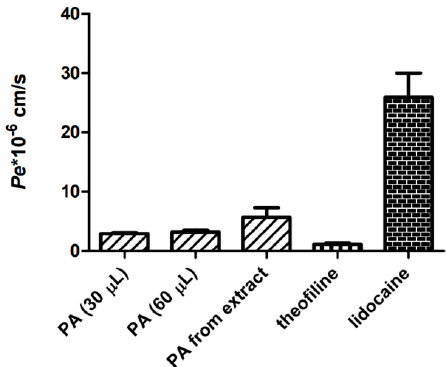
Figure 7. Permeability of pure physodic acid (PA) at different concentrations, physodic acid from extract (PA from extract), and the reference substances: theofiline and lidocaine, examined using PAMPA-BBB model. Results are presented as Pe * 10 − 6 cm/s. The mean values ± SEM from three independent experiments are presented ( n = 3).